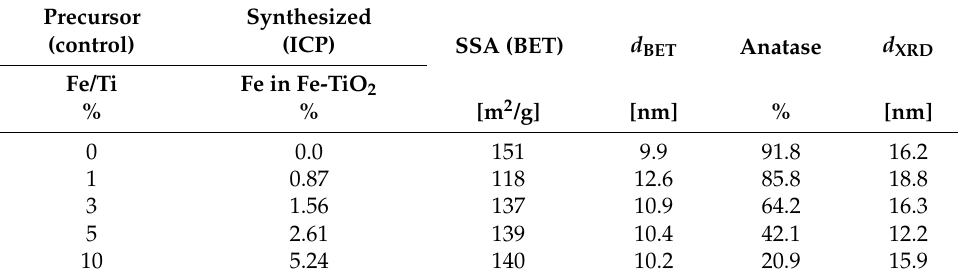
Table 1. Fe-doped TiO 2 synthesis conditions and properties.